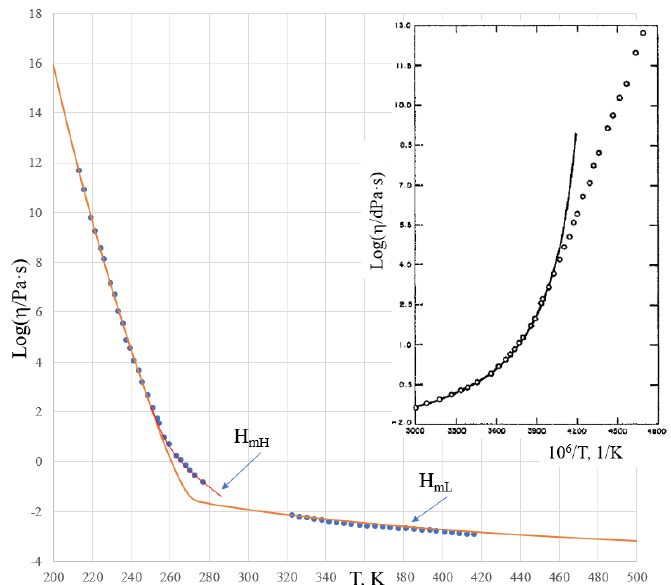
Figure 3. The viscosity of vitreous and molten salol over a wide temperature range. The theoretical curve was calculated using Equation (2), with the same parameters A, H m , C, and H d used at all temperatures. Experimental data were taken from [33] for lower temperatures (T < 280 K) and from [37] for the high temperature range (T > 320 K). The inset shows the viscosity curve by VFT approximation [33].